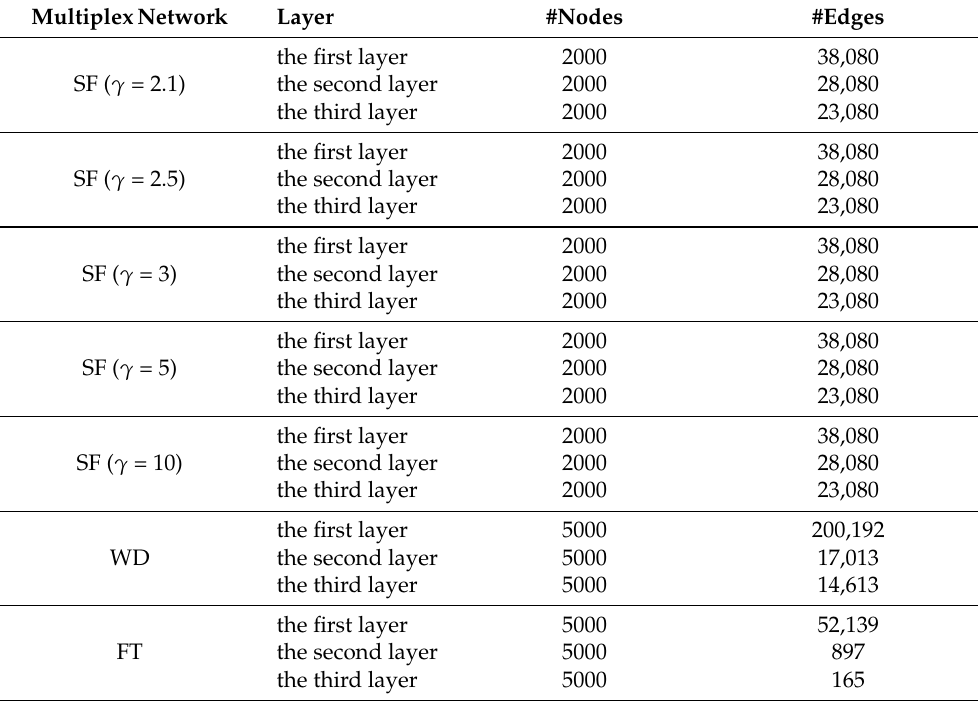
Table 1. The details of the